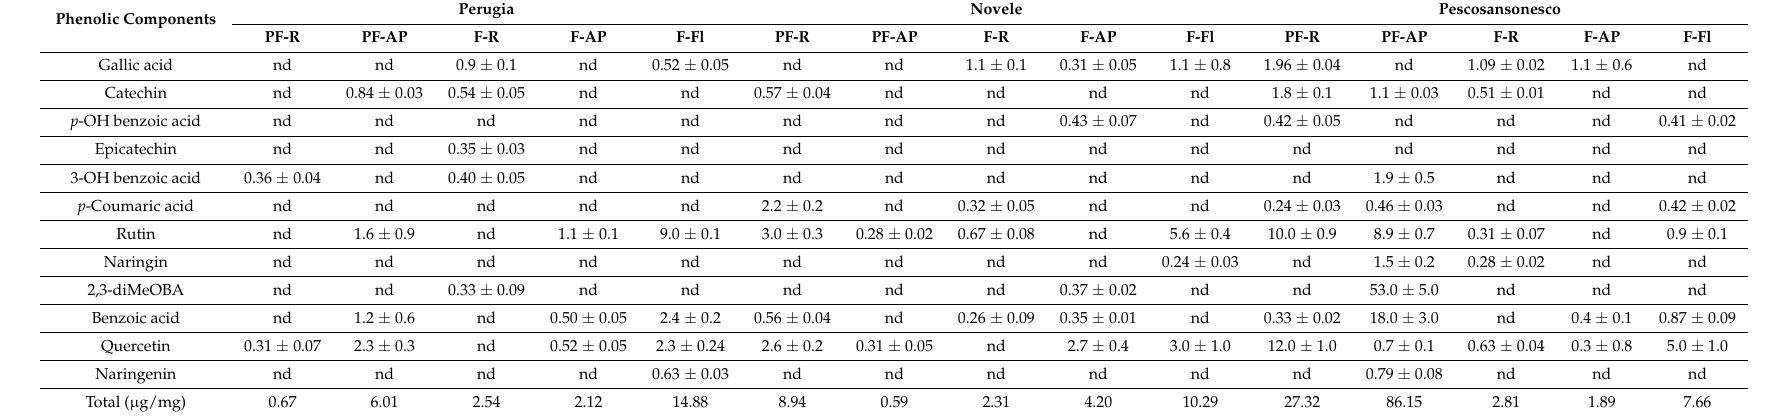
Table 2. Phenolic profile of different parts of A. lutea collected from three different locations in Italy